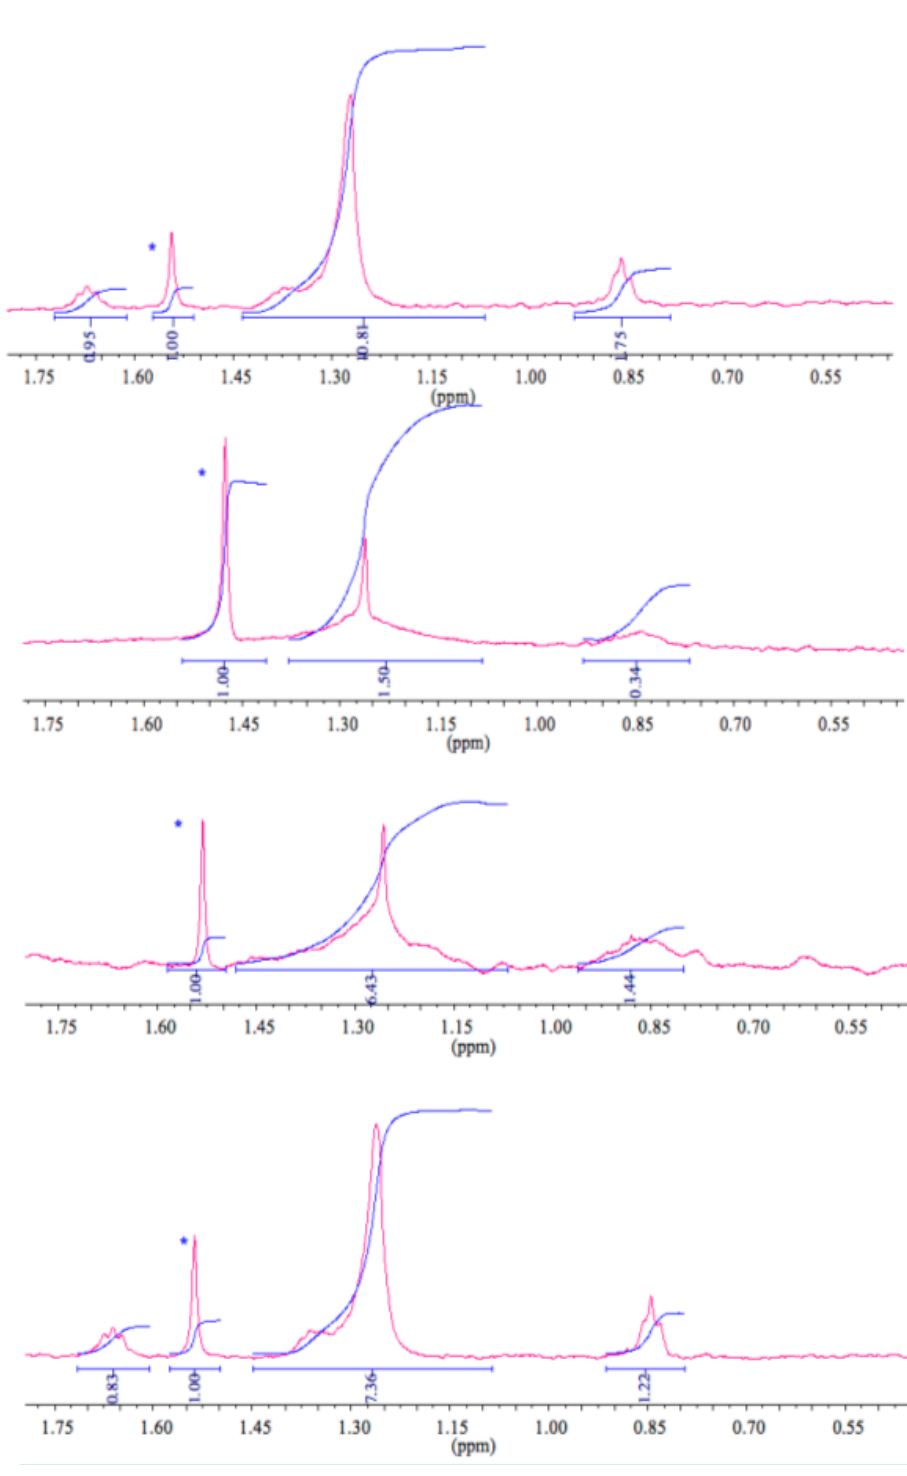
Figure 4. 1 H-NMR spectra of an SDS / CTAB aqueous solution with integration. From bottom to top: 30 °C, 50 °C, 30 °C immediately after transition, and 30 °C two weeks after the transition. Peaks of water included in CDCl 3 are marked with *.